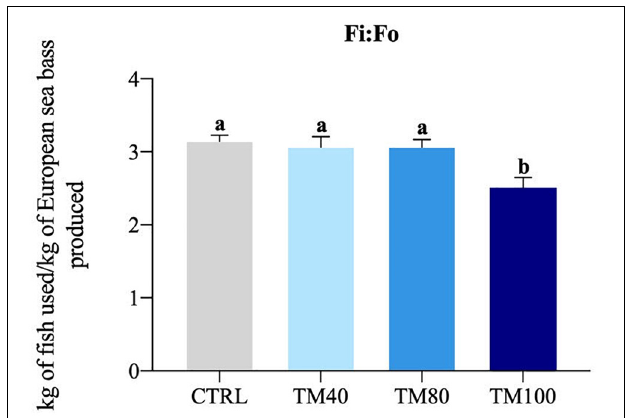
FIGURE 4 | Fi:Fo ratio. Bars represent means ± SD; n = 3 (pools of 5 fish/replicate). Labeled means without a common superscript letter differ significantly, p < 0.05. Fi:Fo was calculated according to Tacon and Metian (2008), assuming yield from forage fish of 24% for FM and 4.8% for